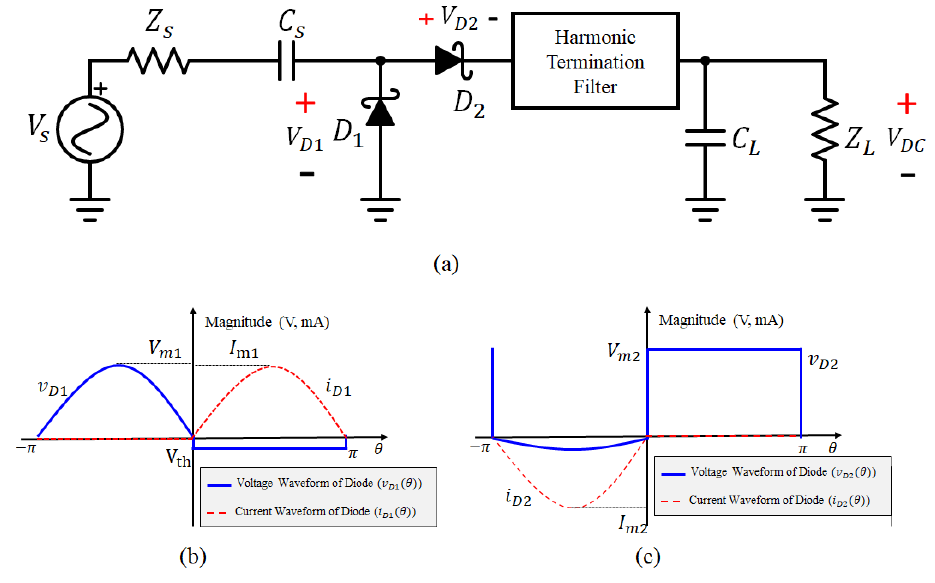
Figure 2. One-stage HTVM circuit diagram and diode waveforms in low power region. ( a ) One-stage HTVM circuit diagram; ( b ) voltage and current waveform of diode D 1 ; and ( c ) voltage and current wave-form of diode D 2